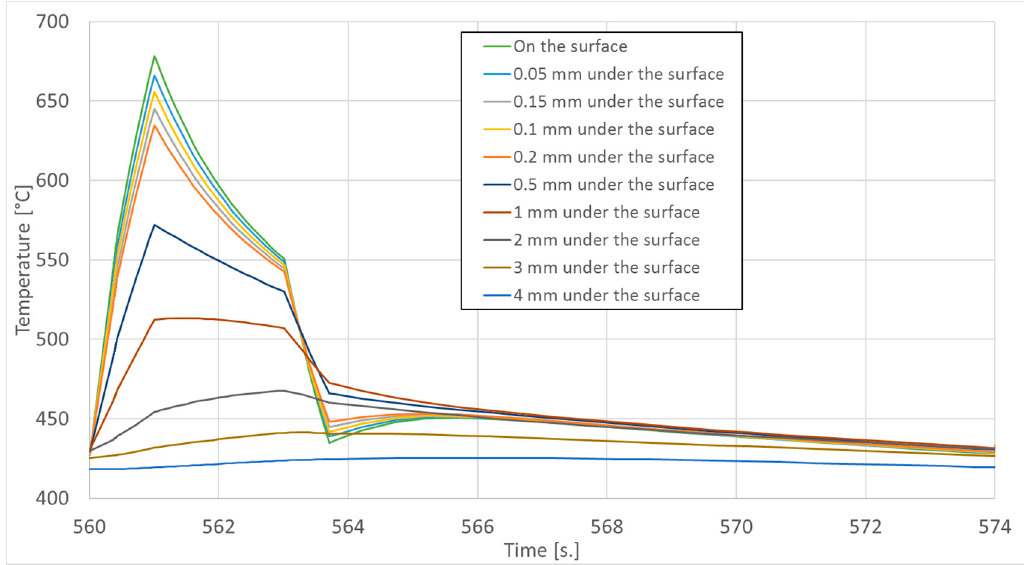
Figure 7. Temperature graph in the last (41st) cycle in the die in the second forging operation.